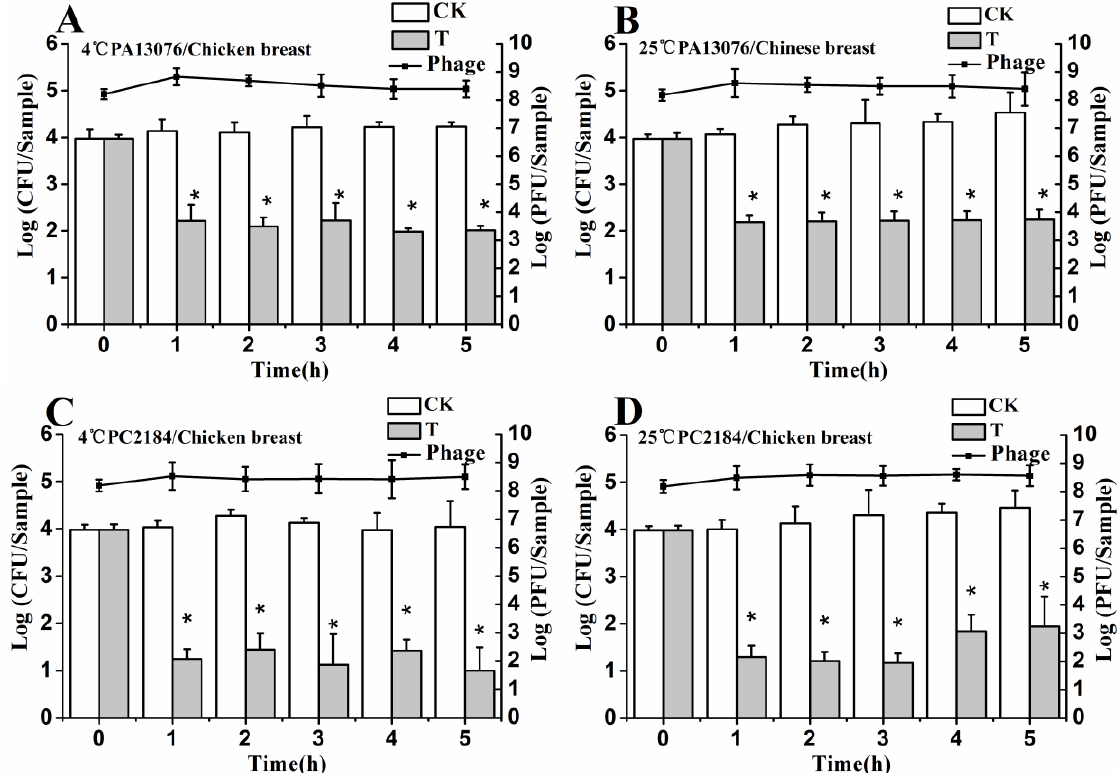
Figure 4. Effects of individual phages on growth of SE ATCC13076 and CVCC2184 on the surface of chicken breast at 4 °C and 25 °C. Each chicken breast sample was inoculated with either SE ATCC13076 ( A , B ) or SE CVCC2184 ( C , D ) (1 × 10 4 CFU), and phage PA13076 or PC2184 was applied (1 × 10 8 PFU) later (CK, inoculated control without phage; T, treated with phage). The titers of phage were also detected each sampling time (indicated in a dotted line). Date represent the mean ± S.D. ( n = 3), * represents p < 0.05 (Duncan’s test).